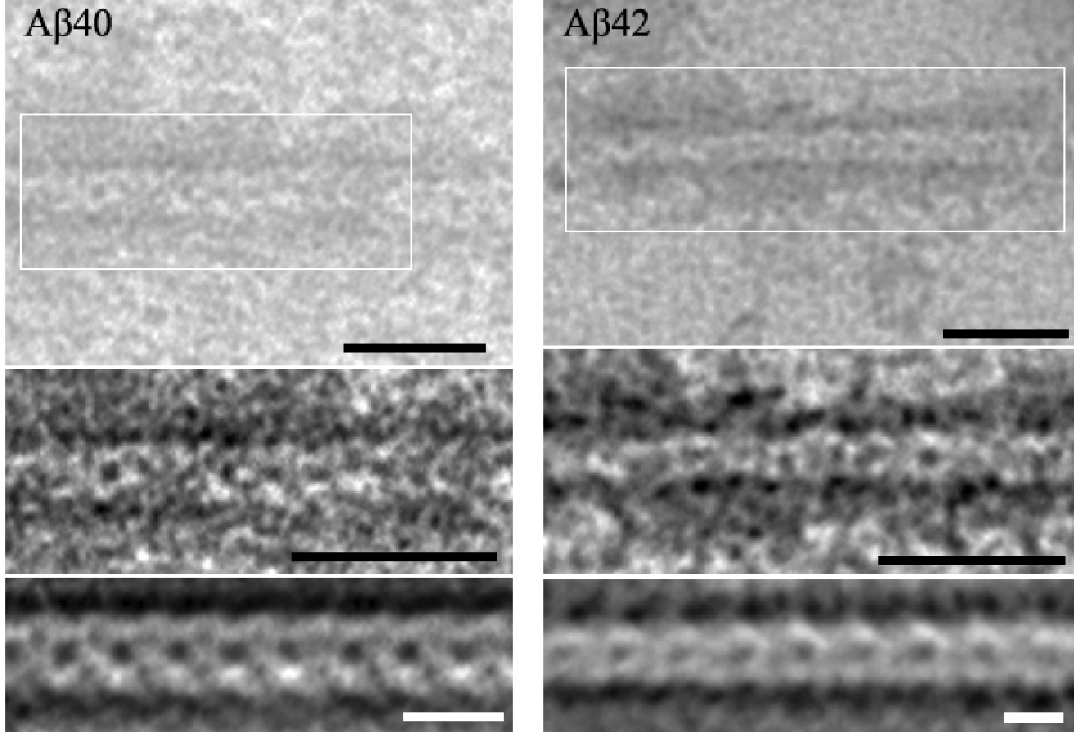
Figure 6. Markham’s method applied to the amyloid fibrils of A β (1–40) and A β (1–42) formed under conditions of 50 mM Tris-HCl (pH 7.0–7.2). Black labels correspond to 25 nm and white ones to 10